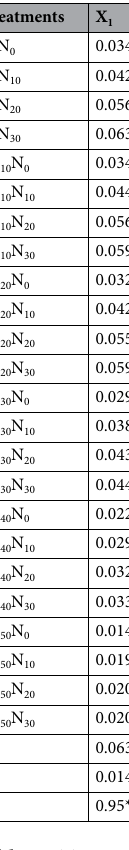
Table 4. TOPSIS analysis of irrigation water applied, yield, water productivity, oil content in kernel, and economic benefit for different irrigation and N application rate treatments for peanut. X 1 , X 2 , X 3 , X 4 and X 5 represent normalized value of pod yield, economic benefit, kernel oil content, irrigation water productivity (WP I ), and amount of irrigation water applied, respectively. Z + and Z − are the positive and negative ideal solutions, respectively. Di + and Di − are the distance between each alternative and positive and negative ideal solution, respectively. C i is the comprehensive benefit evaluation index for different treatments. R is Spearman correlation coefficient between comprehensive benefit index rank and single attribute index rank and the asterisk (*) means that the R was significant at α =